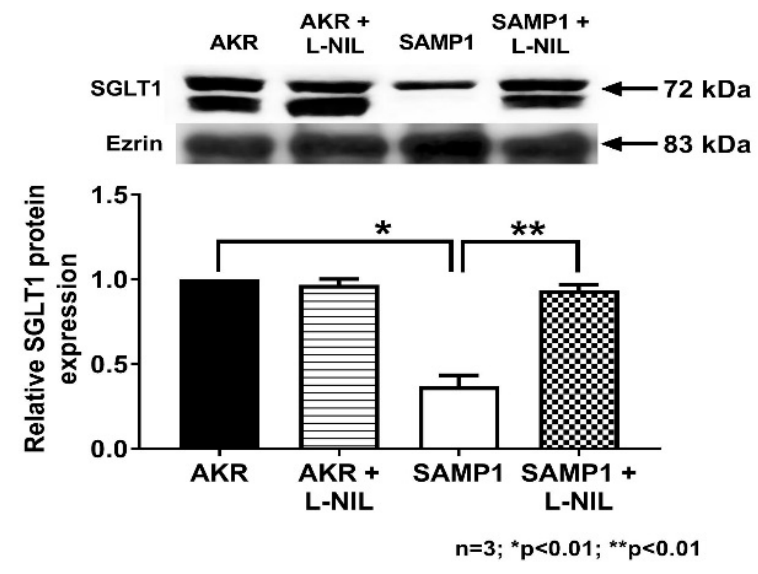
Figure 9. E ff ect of L-NIL on villus cell BBM SGLT1 protein expression during chronic ileitis. The panel on the top is the representative blot that shows that the BBM levels of SGLT1 expression in SAMP1 mice was significantly reduced, and was reversed back to normal levels by L-NIL treatment. BBM SGLT1 levels remained unaltered by L-NIL treatment in AKR mice. Densitometric analysis as shown in the bottom panel confirmed these